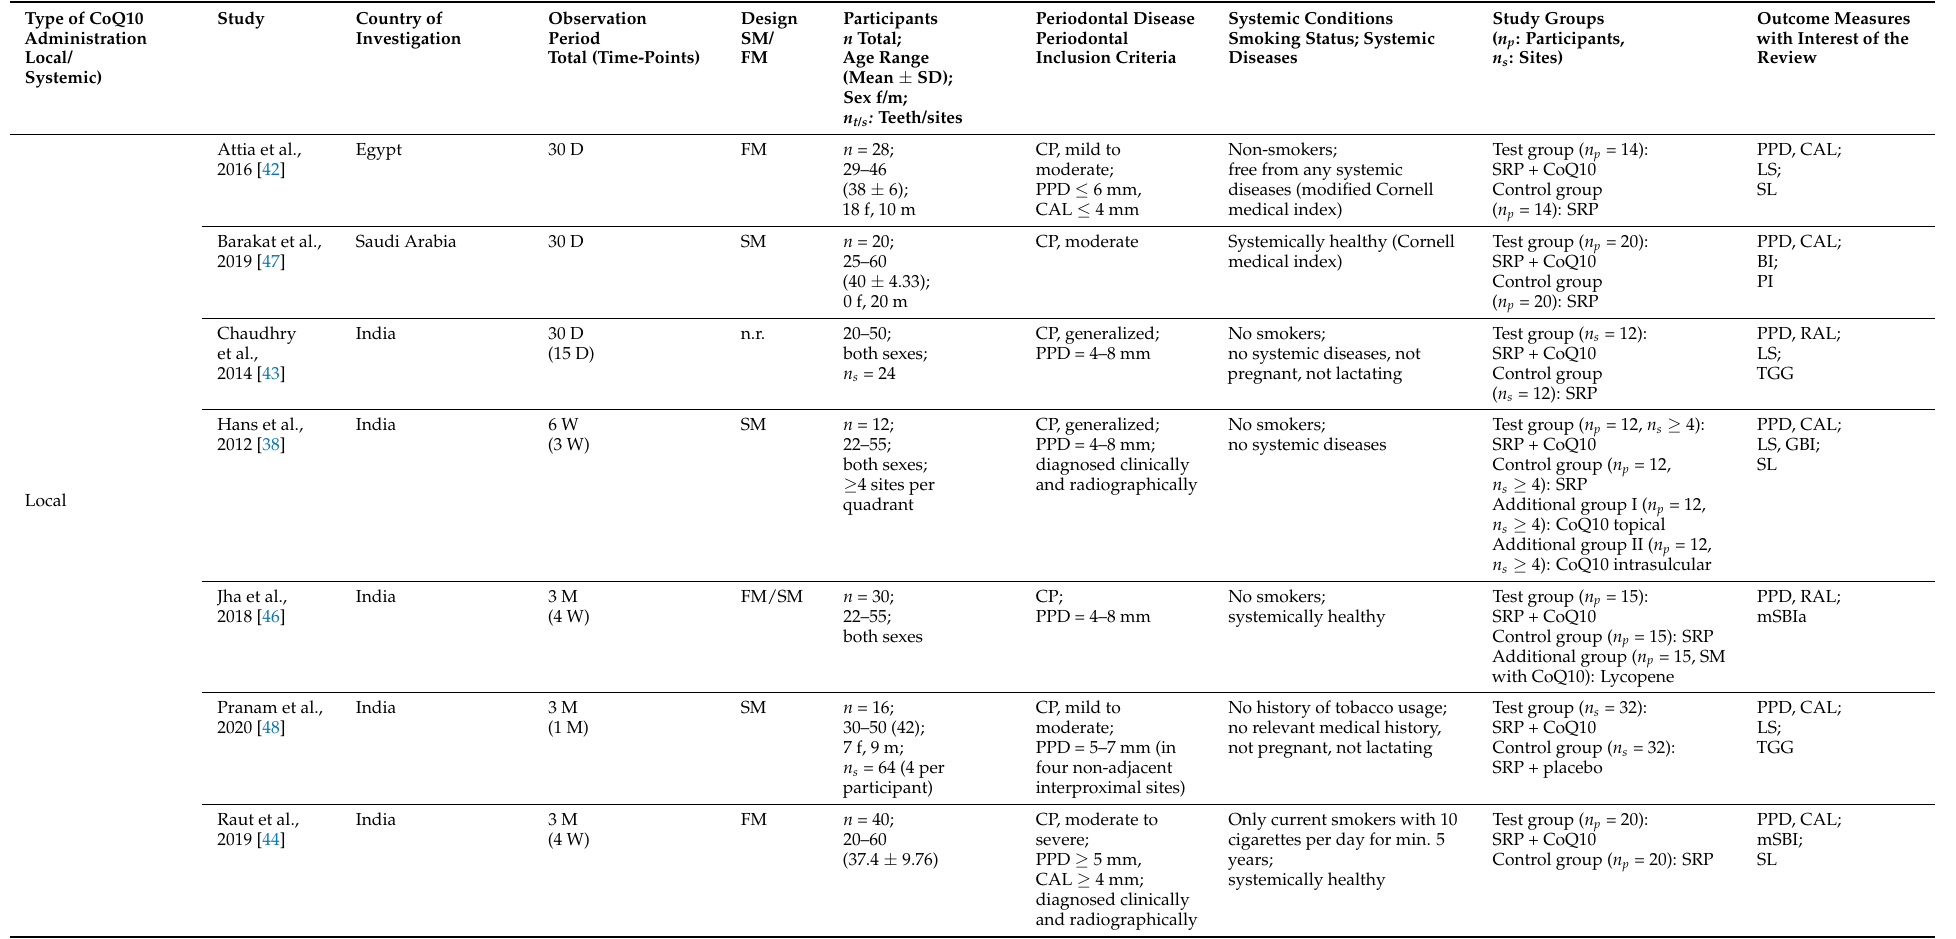
Table 1. Characteristics of the included